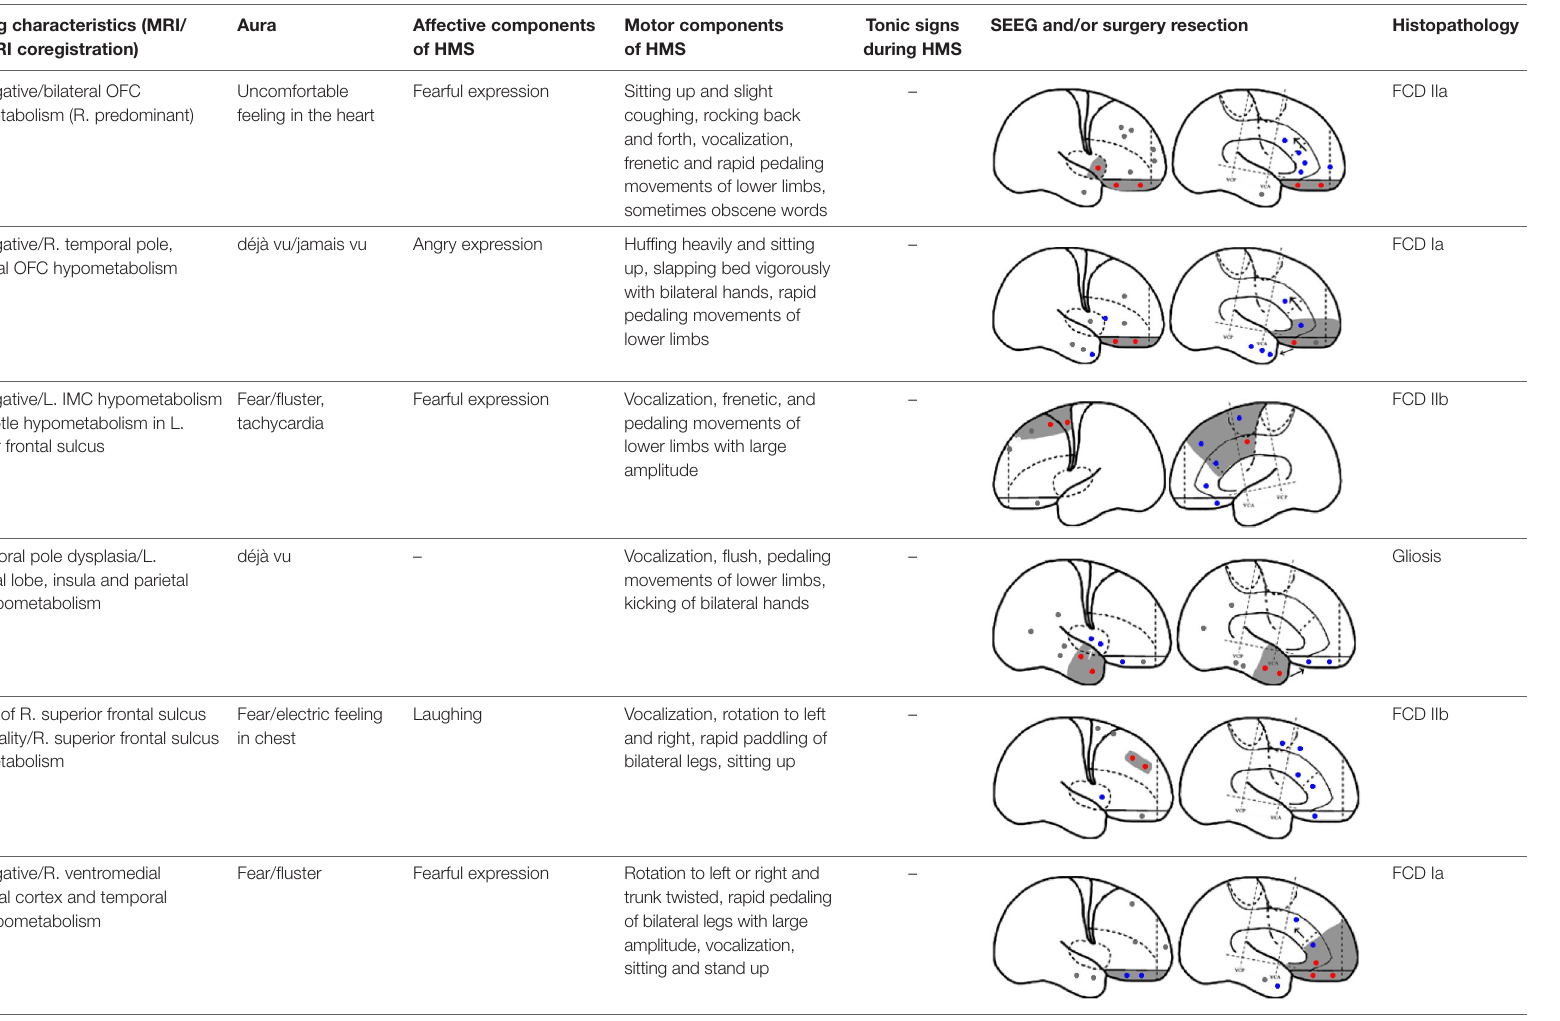
L, left; R, right; SEEG, stereo-electroencephalography; HMS, hypermotor seizures; FCD, focal cortical dysplasia. Dots in the schematic mean location of the SEEG electrodes and arrows refer to the spreading direction. Shaded areas refer to surgical resection site. (Red dots exhibited the electrodes with first clear ictal SEEG onset; blue dots refer to the spreading electrodes at the beginning of HMS